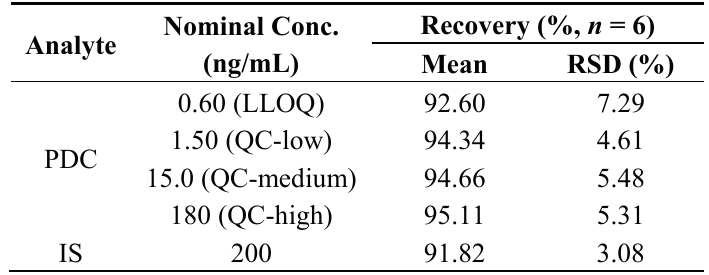
Table 2. The recovery for determination of PDC in rat